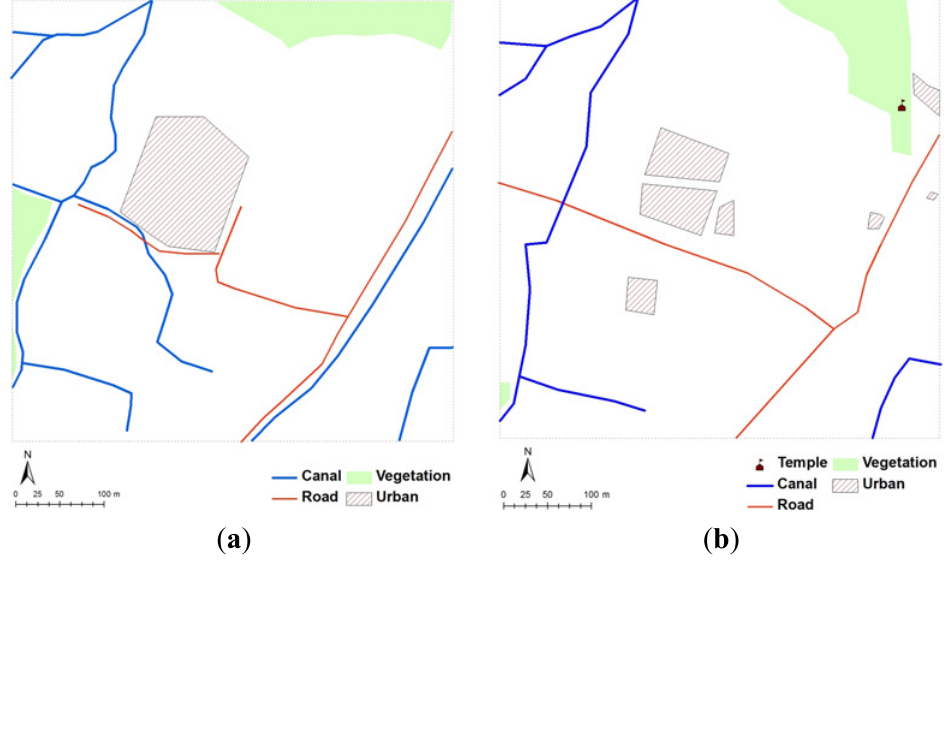
Figure 8. Kacharakanahalli land cover ( a ) 1885; ( b ) 1935; ( c ) 1973; ( d )